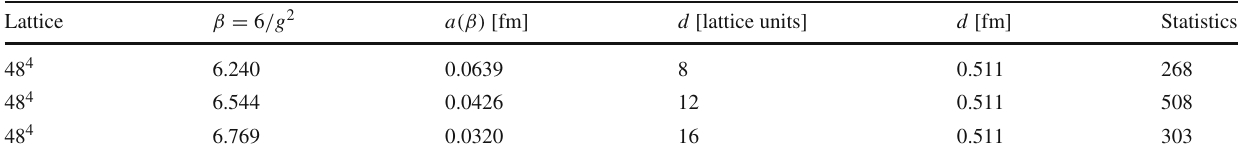
Table 1 Summary of the numerical simulations